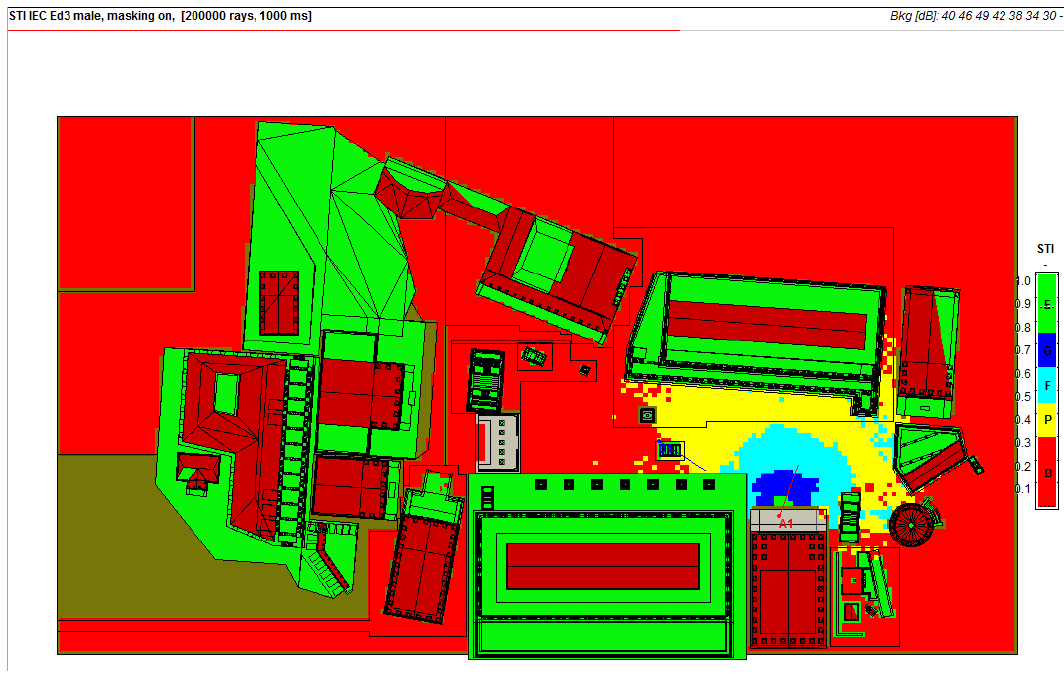
Figure 3. Results of STI analysis for speaker speaking from the podium of the Temple of Castores with “typical audience” background noise. Green marks the area with the STI measure of 0.75–1.00 (‘Excellent’), dark blue marks the area with the STI measure of 0.60–0.75 (‘Good’), light blue marks the area with the STI measure of 0.45–0.60 (‘Fair’), yellow marks the area with STI measure of 0.30–0.45 (‘Poor’).